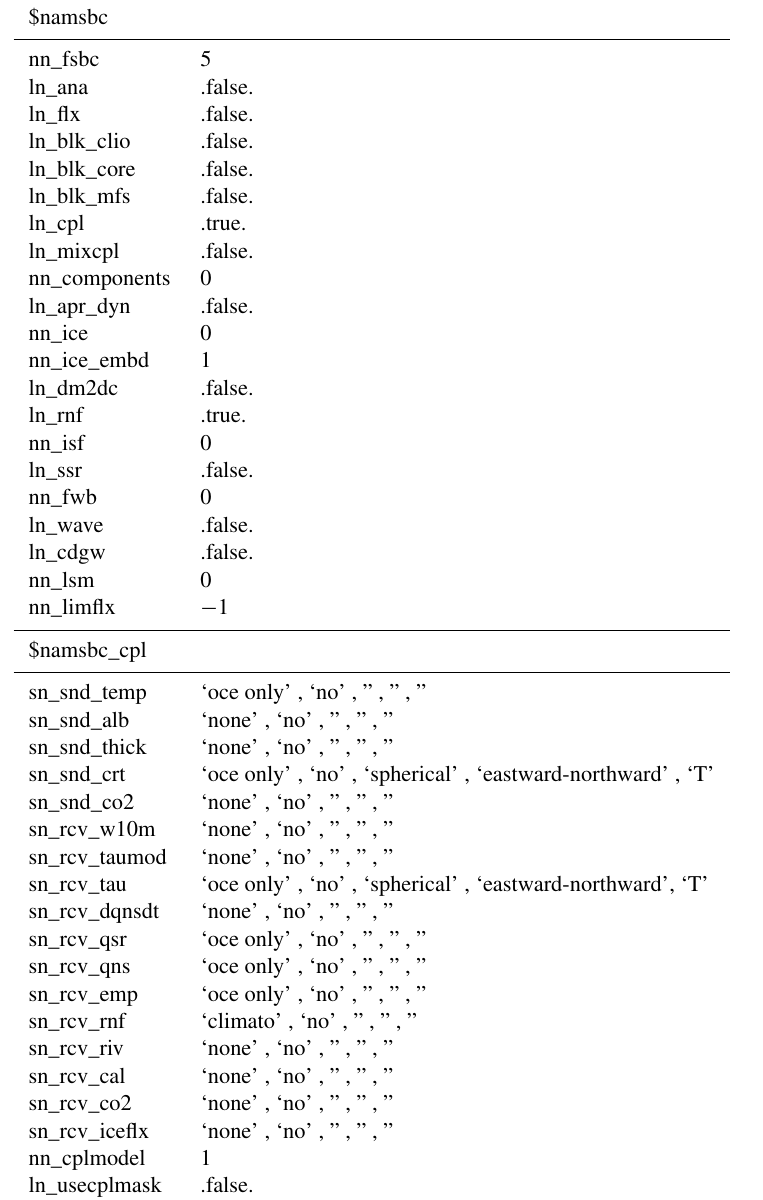
Table A3. NEMO namelist (namelist_cfg) parameters used for coupling (AOW